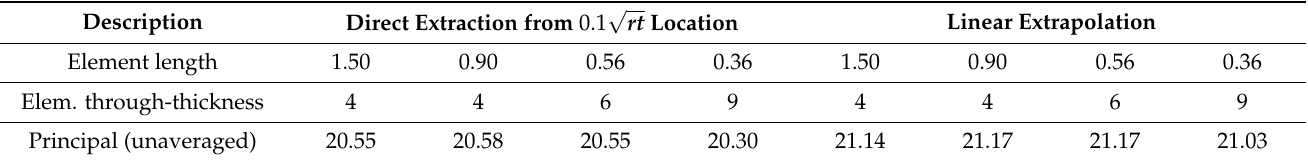
Table 5. Chord side saddle SCFs based on Mises and principal stresses for second-order